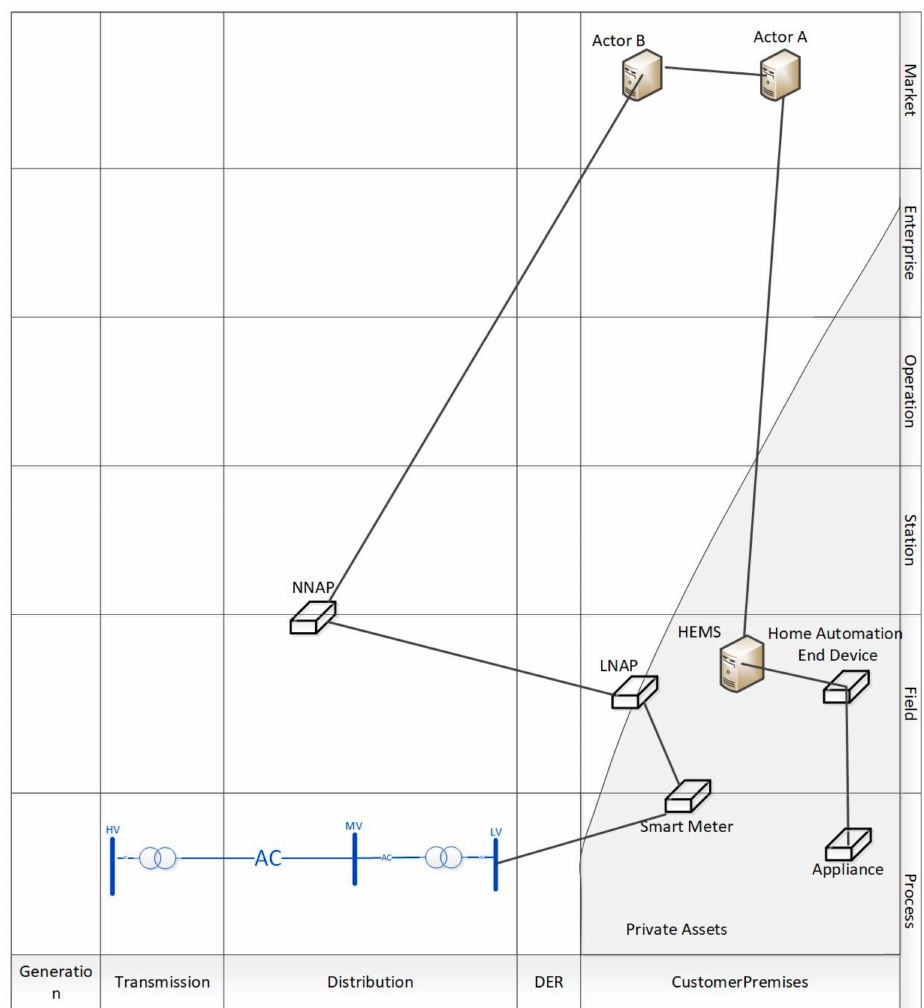
Figure 3. Representation of the use case on the SGAM component